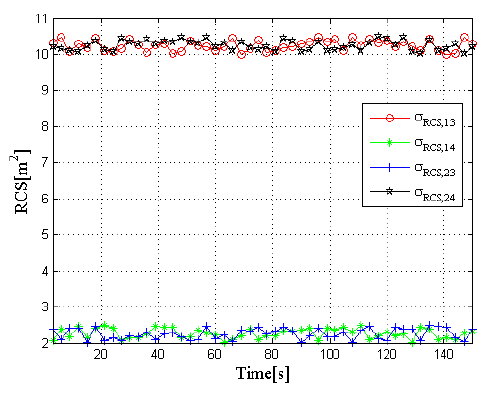
Figure 7. RCS case 2.